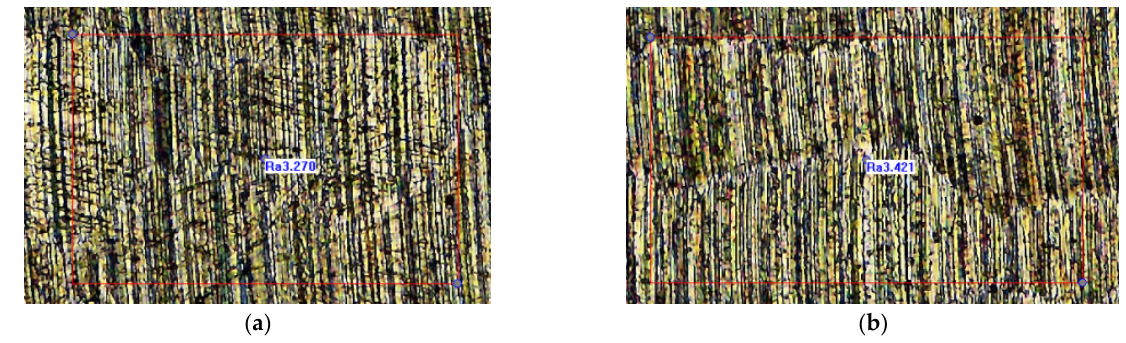
Figure 18. Workpiece surface roughness: ( a ) workpiece machined by DACT; ( b ) workpiece machined by BEM.